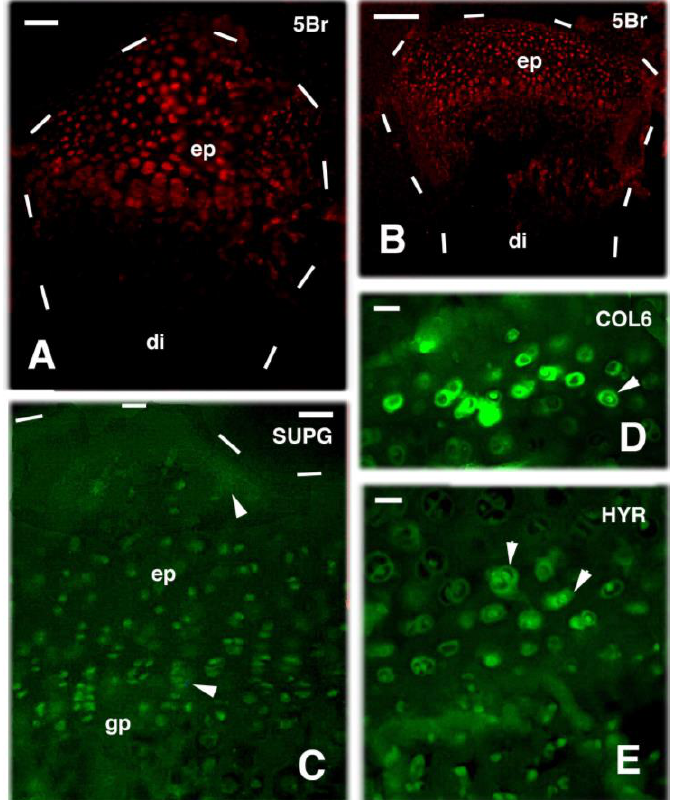
Figure 5. TRITC immunofluorescence after 4 h post-injection of 5BrdU ( A , B ) and FITC immunofluorescence for cartilaginous markers ( C – E ) in regenerating cartilages of the epiphyses in injured knees. ( A ) at 32 days post-injury, the regenerated epiphysis of a tibia shows numerous labeled cells (5Br). Bar, 20 μm; ( B ) at 32 days after injury the knee epiphysis is rich in labeled cartilaginous cells (5Br). Bar, 50 μm; ( C ) at 28 days post-injury the immunofluorescence for Condroitin Sulphate Proteoglycan, SUPG) is present in chondrocytes and weakly in the extracellular matrix (arrowheads) of the epiphysis. Bar, 20 μm; ( D ) immunofluorescence for collagen VI (COL6) is variable in regenerating chondrocytes but is intense in the ring-shaped pericellular matrix (arrowhead). Bar, 10 μm; ( E ) hyaluronate receptor immunolabeling (HYR) is detected in sparse chondrocytes and isogenous group, with the fluorescence concentrated intracellularly and in the pericellular region (arrowheads). Bar, 10 μm. Legends: di, diaphysis; ep, epiphysis; gp, growth plate (metaphyseal plate). Dashes outlined the shape of cartilages and bones.